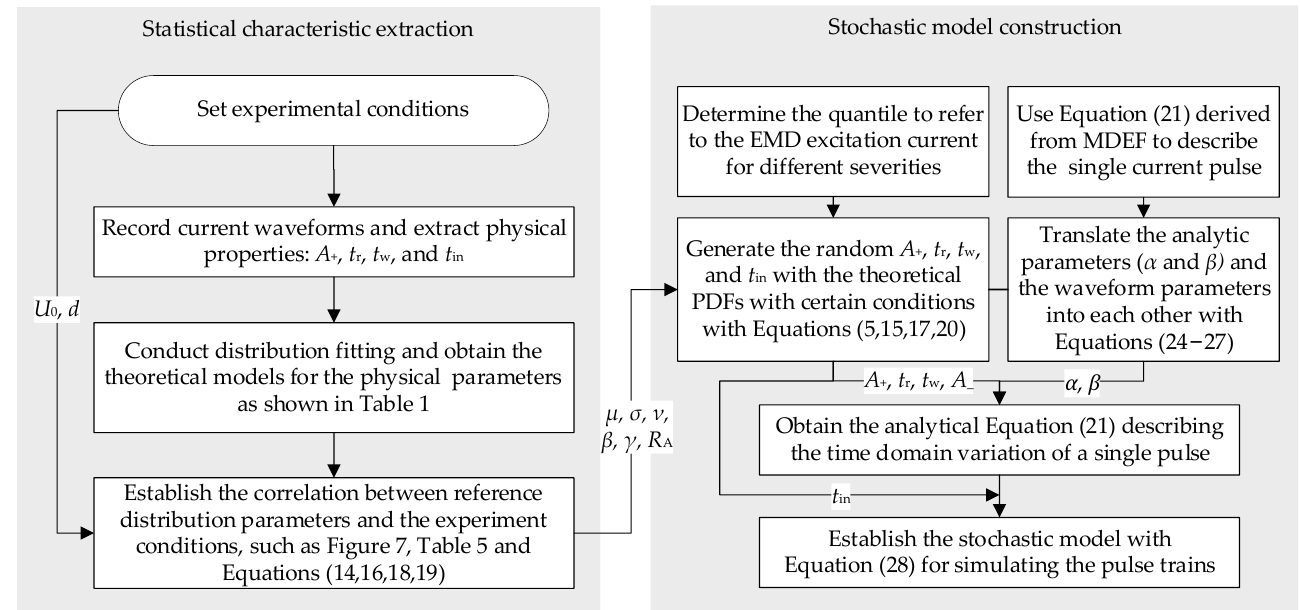
Figure 14. Flowchart of the calculation of the time domain waveform of discharge current.